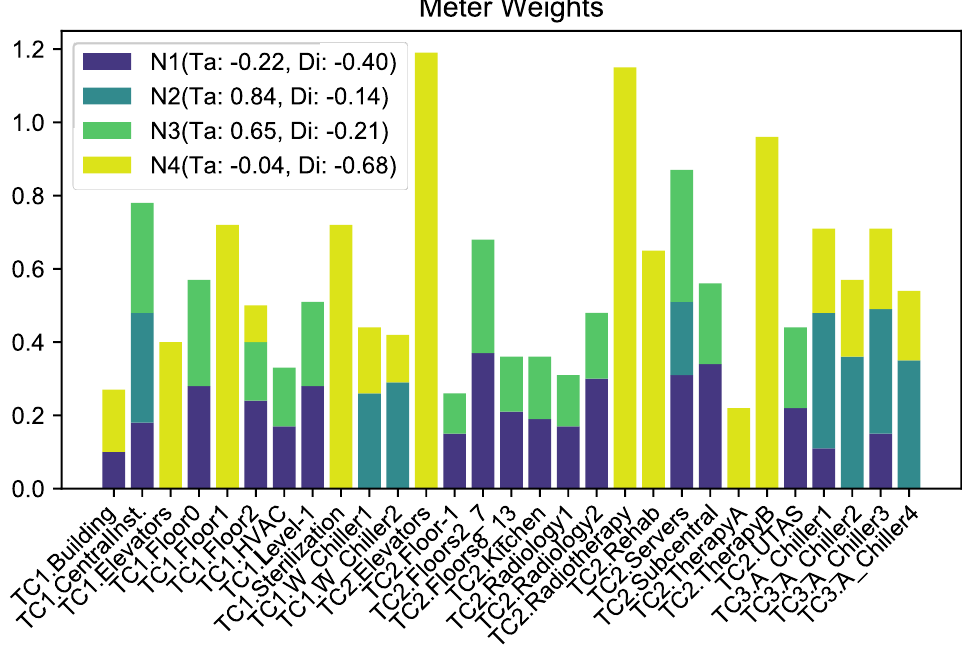
Figure 9. Results of the pointwise convolution (weights and